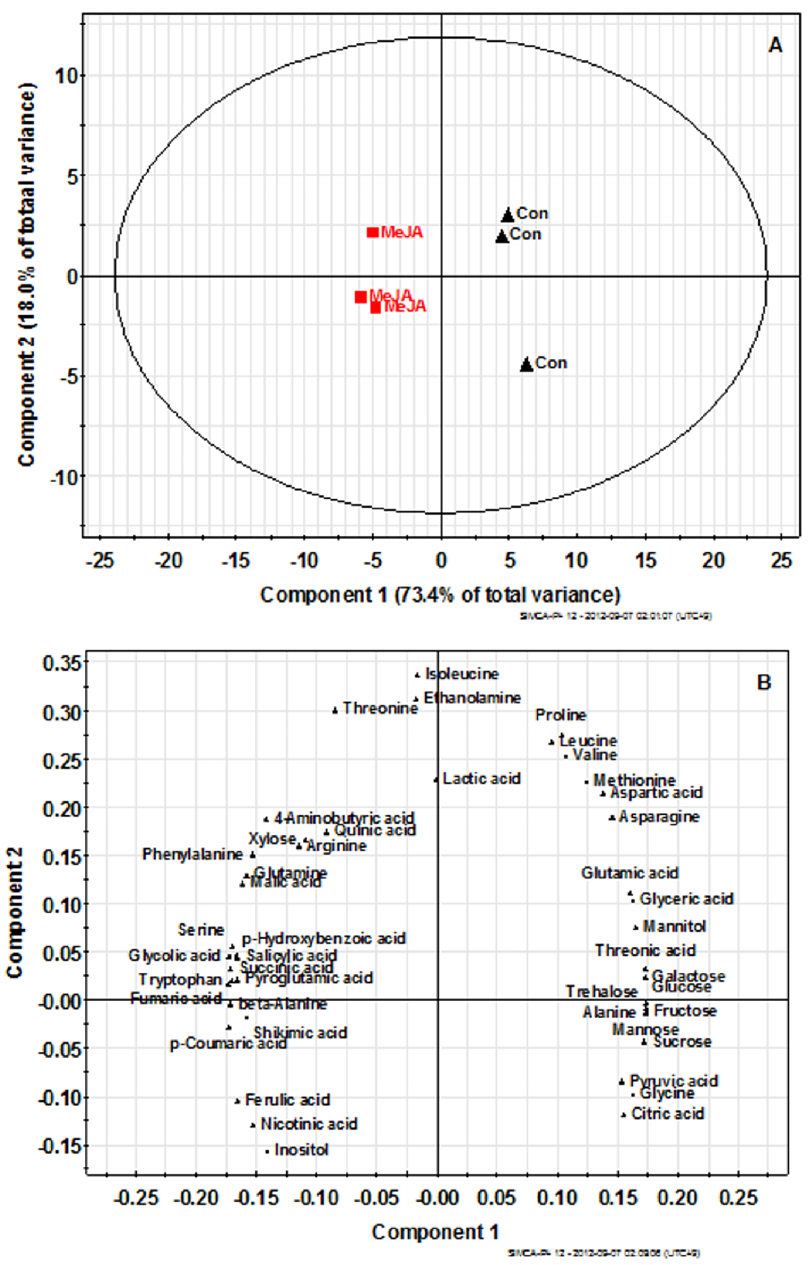
Figure 5. Scores (A) and loading plots (B) of principal components 1 and 2 of the PLS-DA results obtained from polar metabolite data of the MeJA-treated A.rugosa cells and control